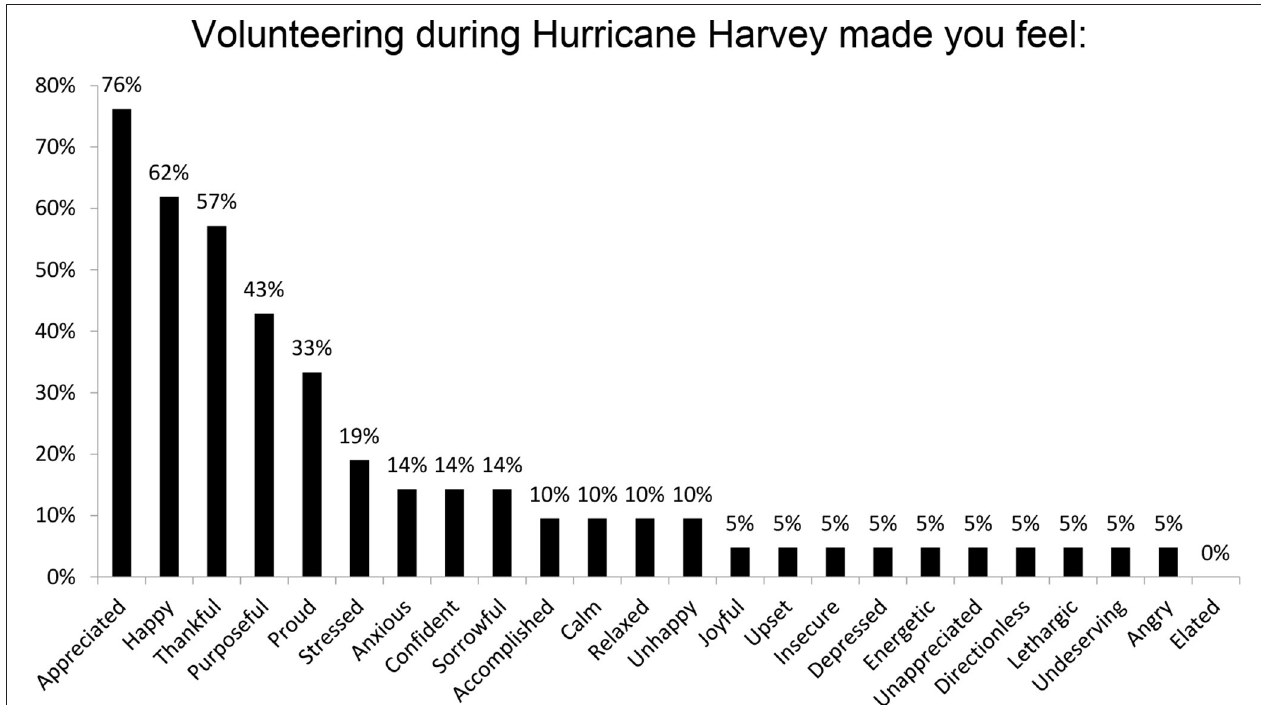
FIGURE 4 | Volunteerism led to greater feelings of appreciation and well-being. Survey responders were able to select any and all of the feelings which applied.